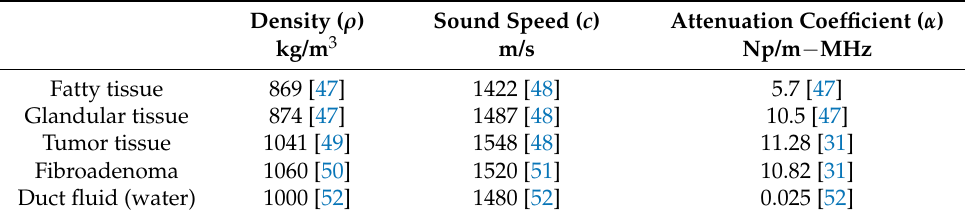
Table 1. Material properties of all tissues and duct fluid.